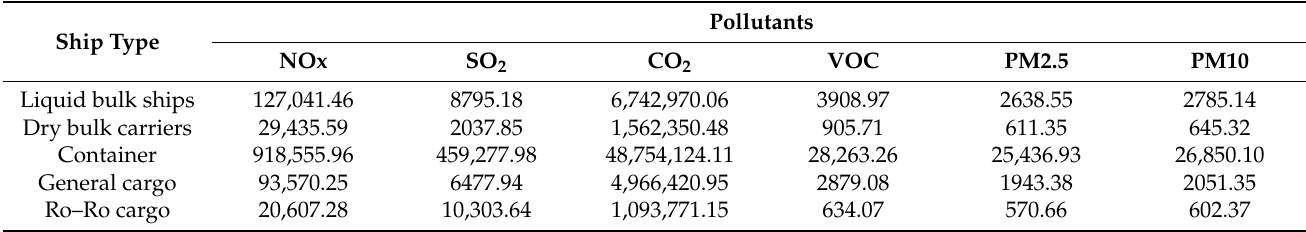
Table A2. Ship pollutant emissions by ship type at Busan Port in 2016 (ship activity phase: Hoteling)